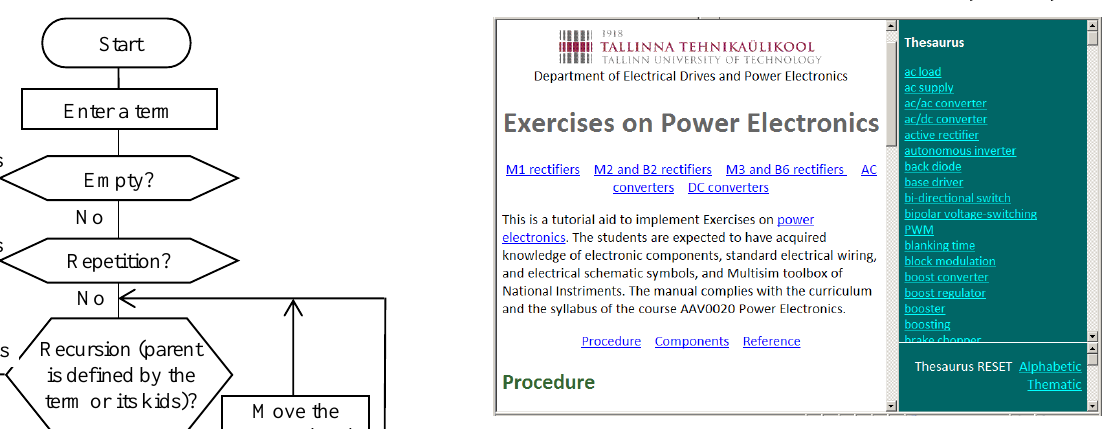
Fig. 3. Fragment of the ET-based online manual for exercises in Power Electronics.